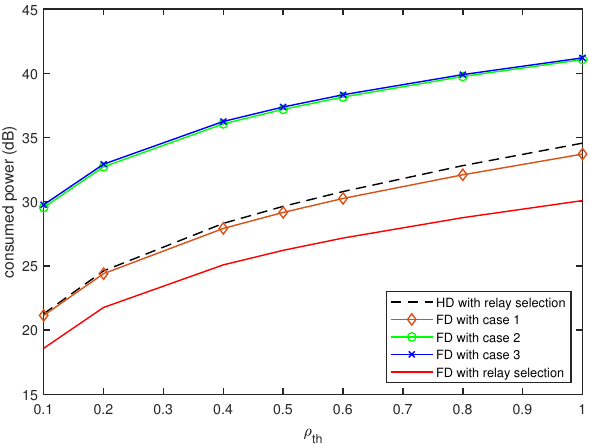
Figure 5. Comparison of power consumption as a function of ρ th ( d =